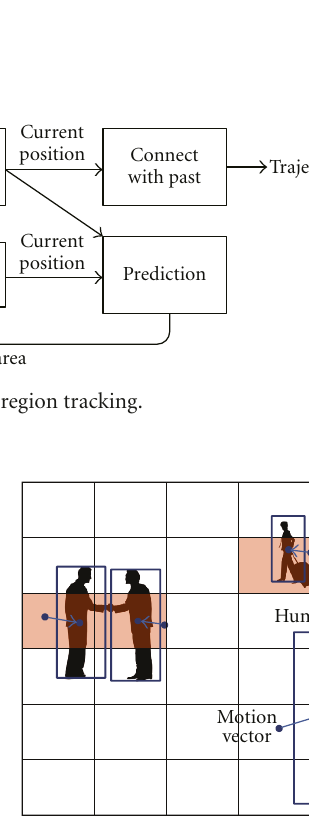
Figure 14: Concept of calculating an average velocity